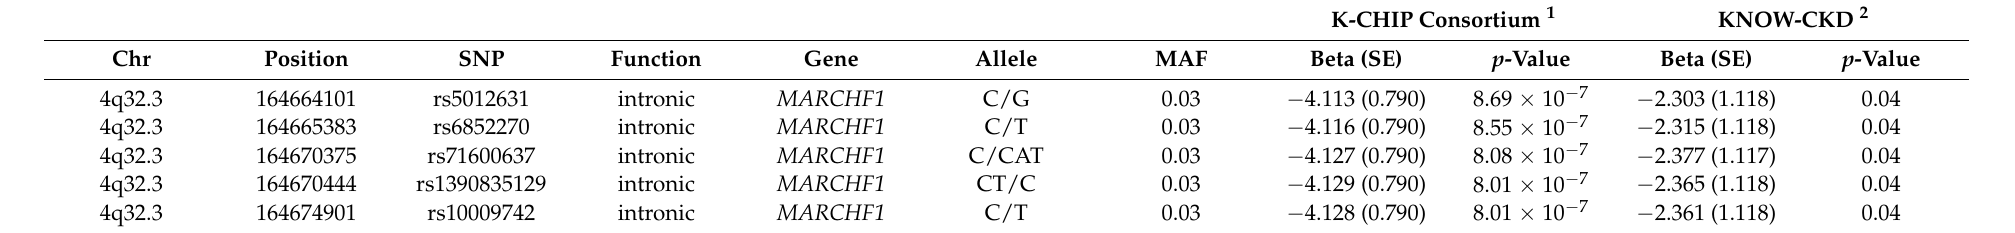
Table 2. Significant SNPs associated with rapid eGFR decline based on the genome-wide association study.